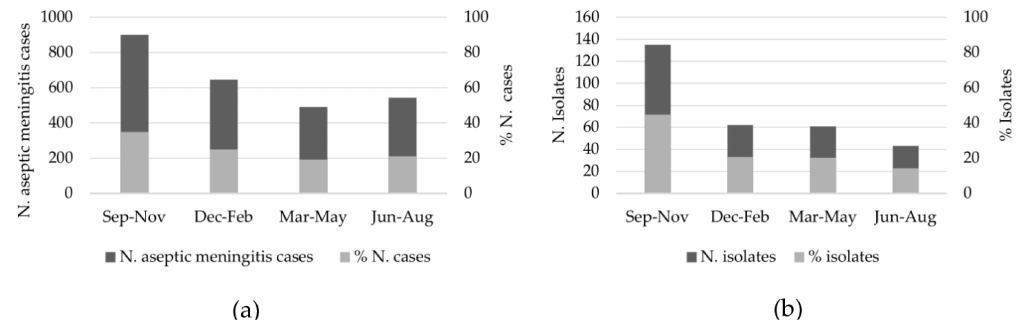
Figure 1. Seasonal distribution of aseptic meningitis cases in Brazil from 2013 to 2017 for all patients ( a ) and EV-positive patients ( b